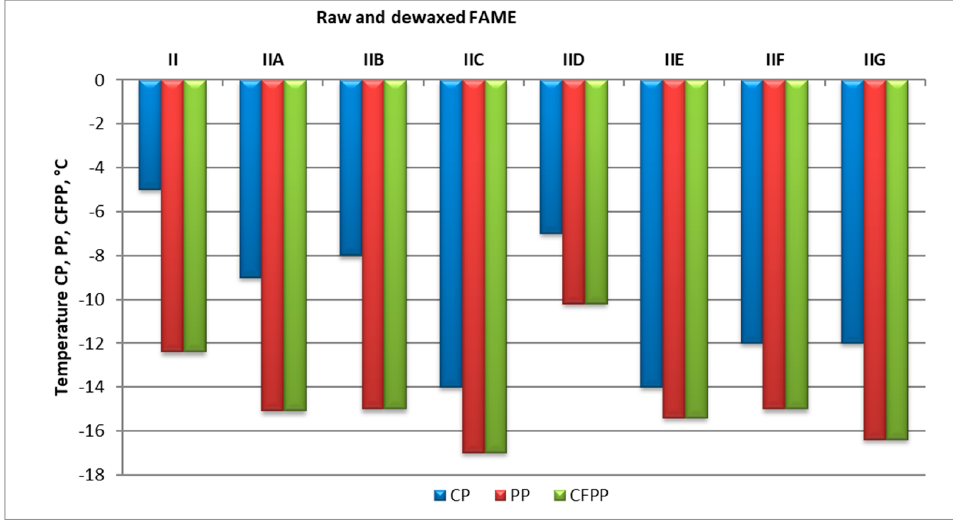
Figure 3. Low-temperature properties of raw FAME II and modified biofuels.